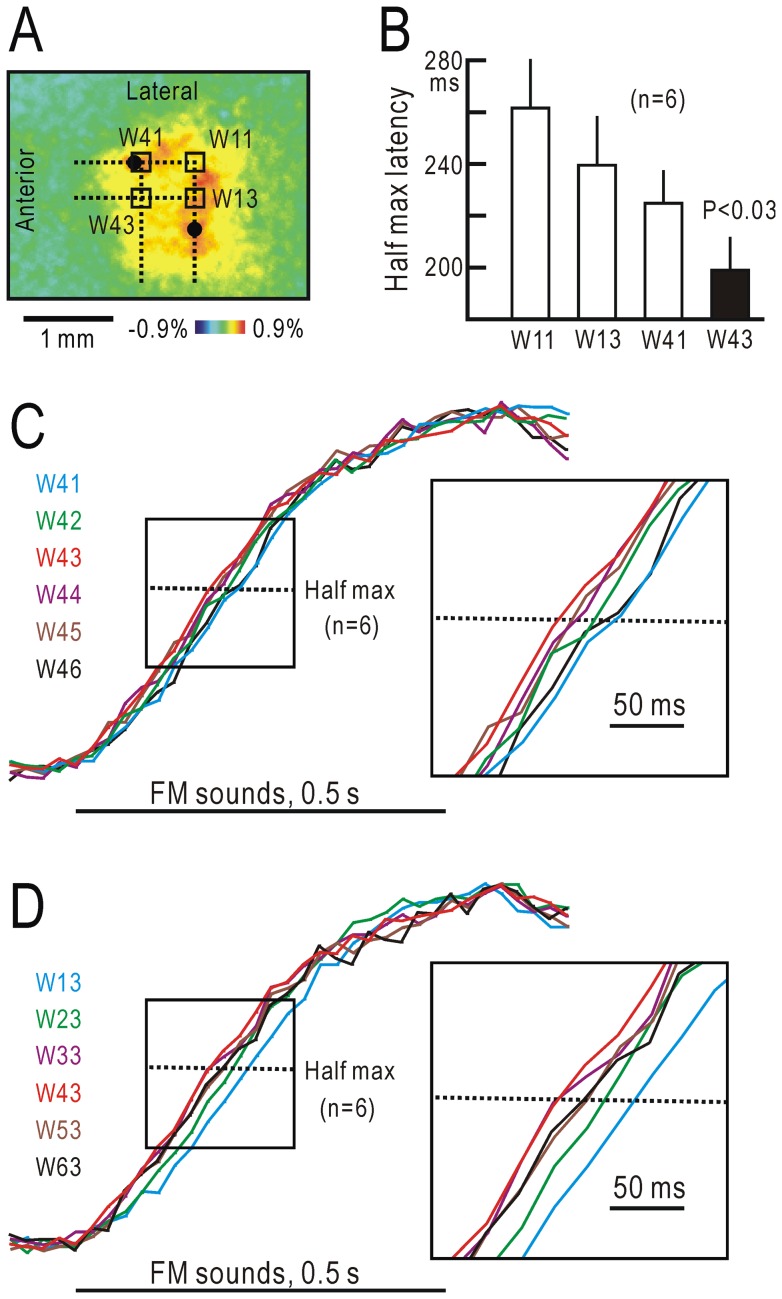
Half-max latency for cortical responses to FM sweeps.(A) Window (0.26 by 0.26 mm) position for measuring half-max latency to FM sounds ranging from 5 kHz to 40 kHz, and from 40 kHz to 5 kHz for a period of 0.5 s. Windows are shown on the image with the response to a 20 kHz AM sound. Black spots show the response peaks in A1 and AAF. W11 was located at the crossing point of an anterior-posterior line passing through the peak in AAF and a medial-lateral line passing through the peak in A1. The cortical area around UF was covered by the 36 windows (W11∼W66). (B) Half-max latency measured at W11, W13, W41 and W43. The latency at W43 was significantly shorter than that at W11, W13 or W41 (P<0.03, respectively). Responses to FM sounds ranging from 5 kHz to 40 kHz, and from 40 kHz to 5 kHz were averaged to reduce variability in data. (C) Time courses of fluorescence responses at W41∼W46. Inset shows twice-expanded traces around the half amplitudes. (D) Time courses of fluorescence responses at W13∼W63.